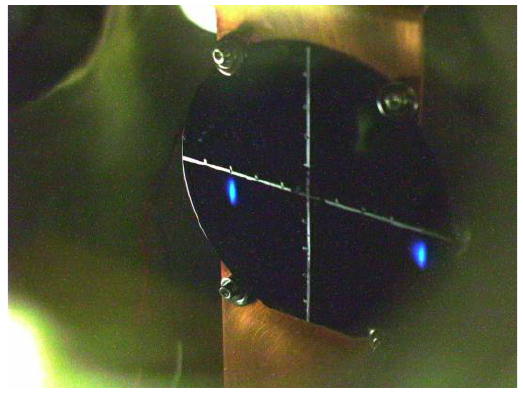
Fig. 3. Picture of a SiO 2 scintillator placed inside the IMP chamber. The two blue spots are the positions where the beam is most of the time.